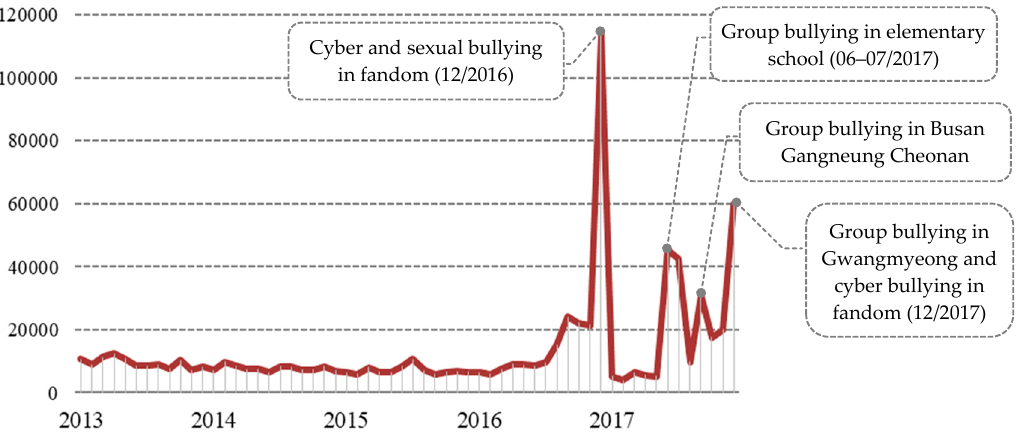
Figure 2. Web-document occurrence from 2013 to 2017.